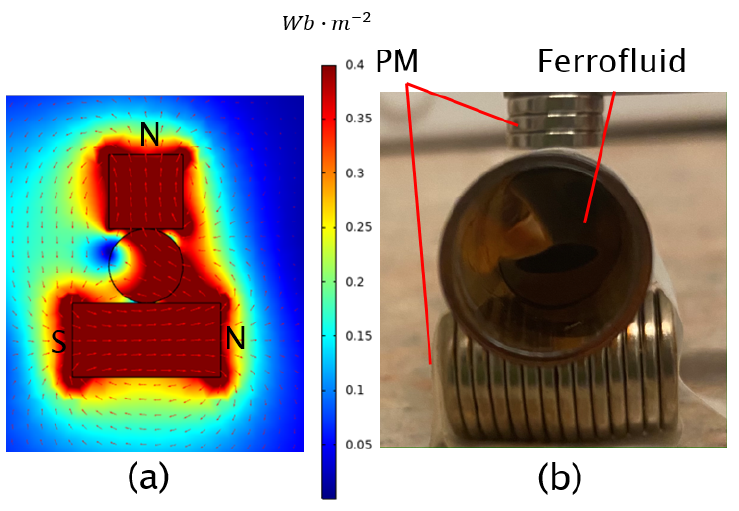
Figure 10. Geometry analysis of ferrofluid. ( a ) Simulation model for magnetic flux. ( b ) Experimental shape of